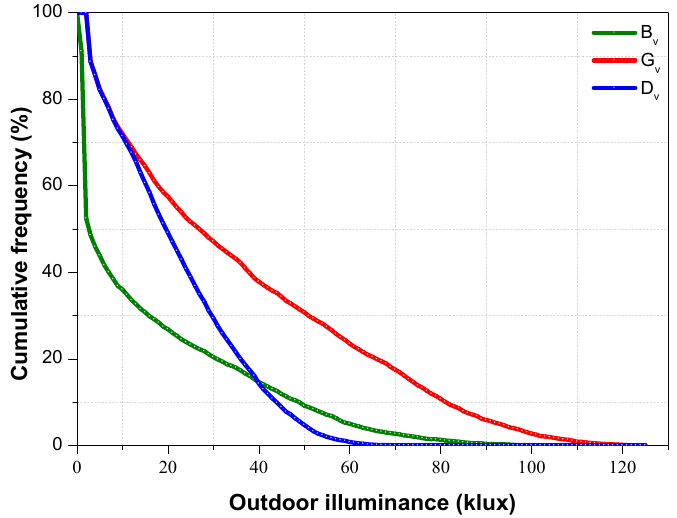
Figure 7. Cumulative frequency of horizontal outdoor illuminance .